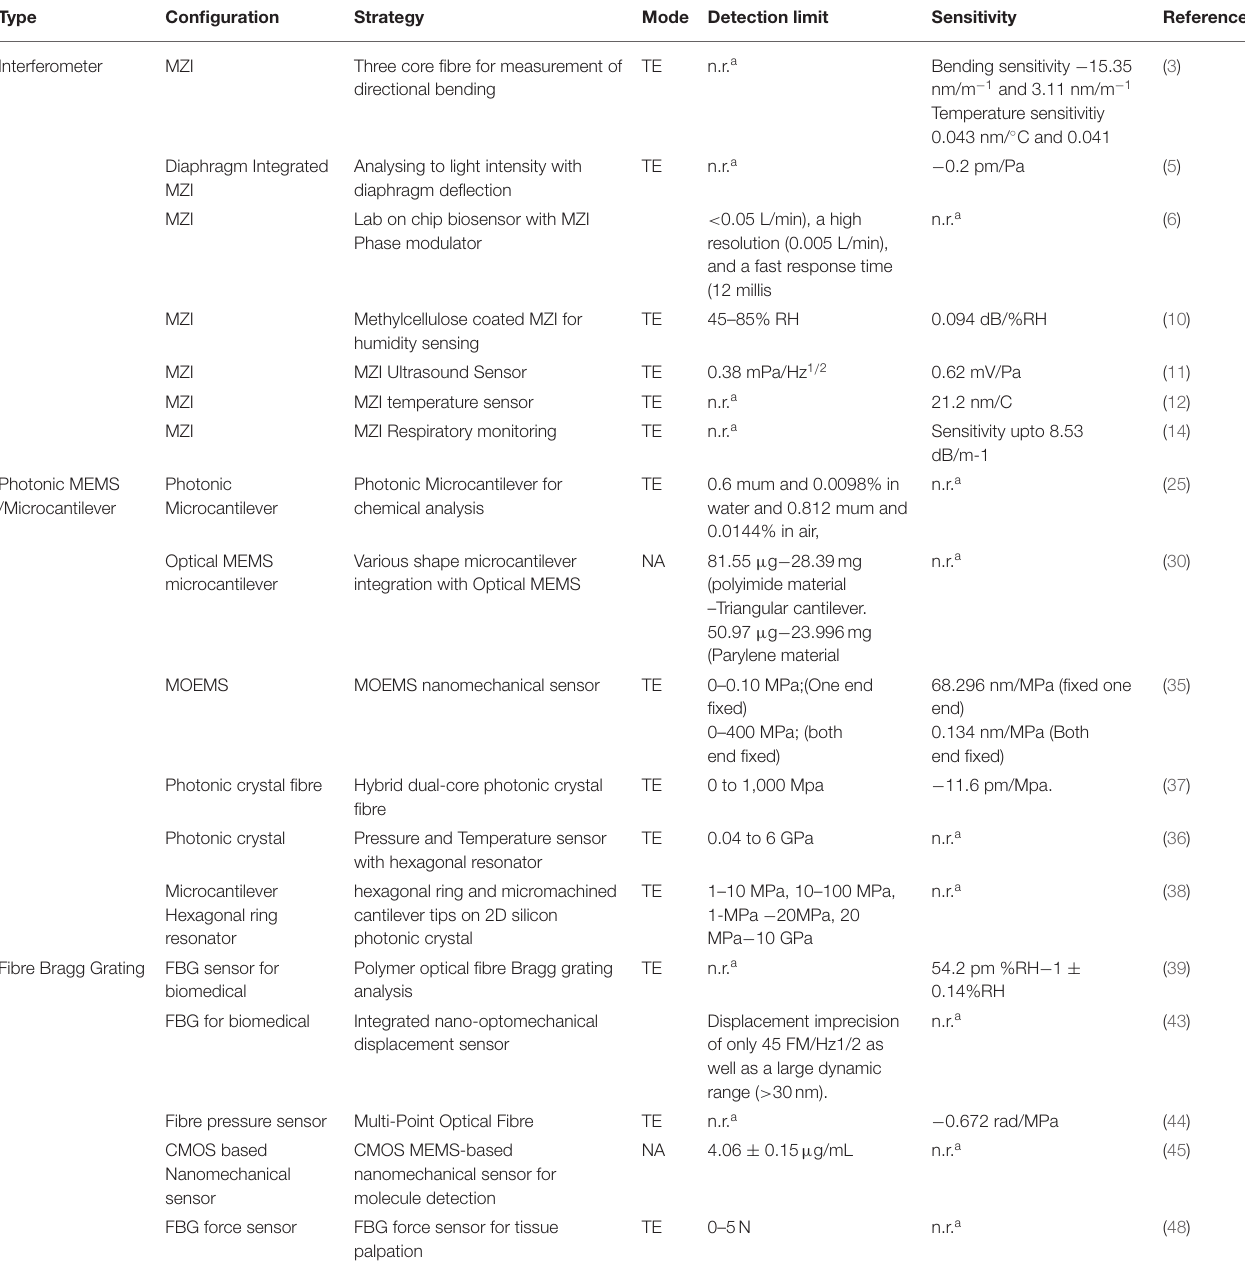
TABLE 1 | Performance comparison of selected